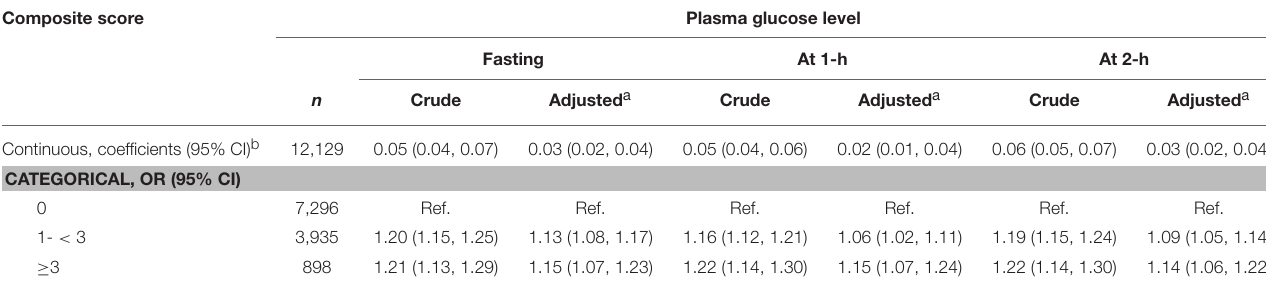
TABLE 4 | Adjusted coefficients and odds ratios for associations between maternal glycemia and composite maternal-birth outcomes. Composite score Plasma glucose level Fasting At 1-h At